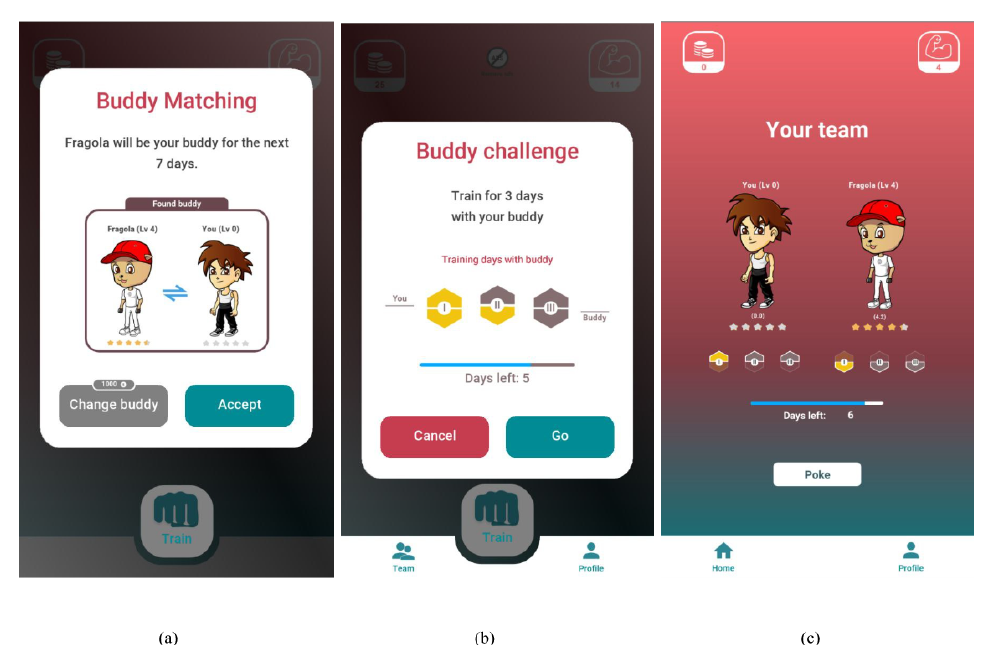
Figure 2. Screenshot of the app: Buddy Version (B). ( a ) the match with a new buddy, ( b ) the progress of the week goal, ( c ) the team